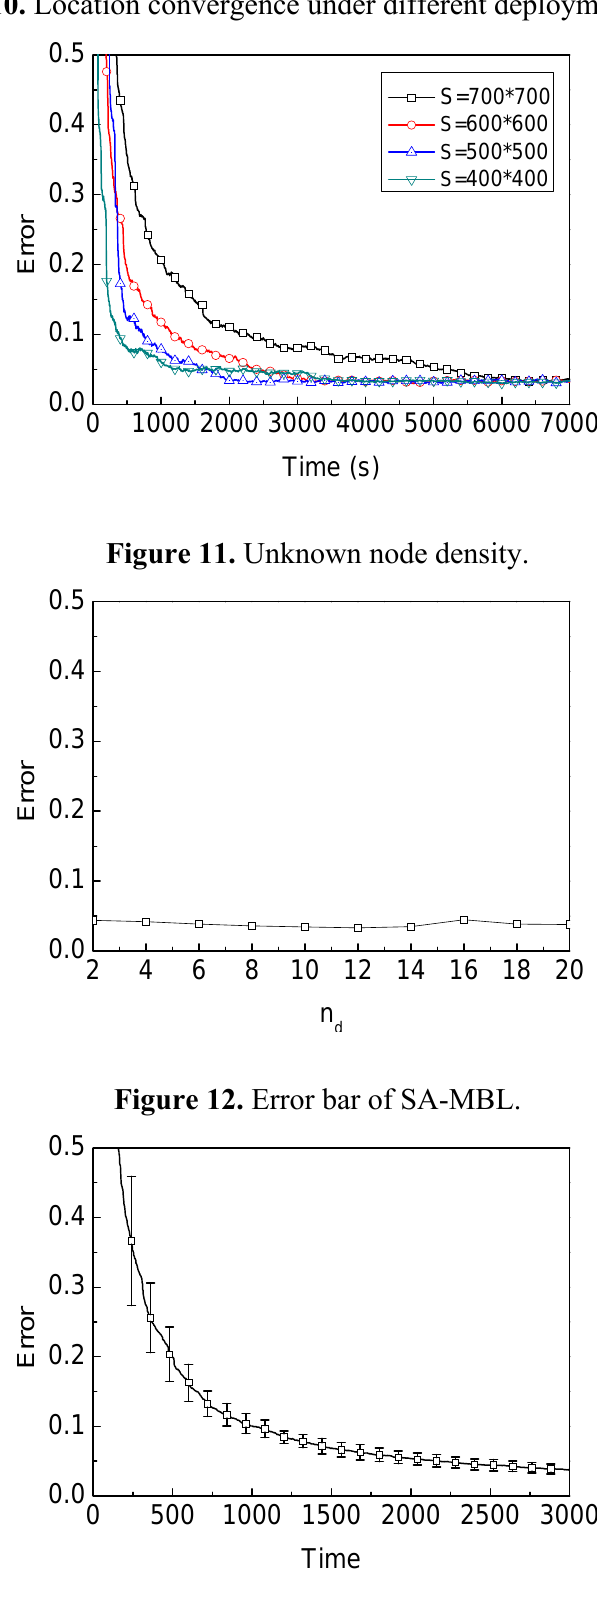
Figure 10. Location convergence under different deployment regions.